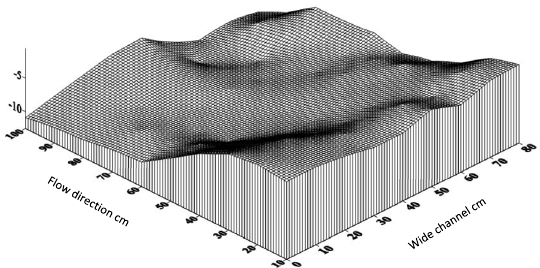
Fig. 6 3D model of bed channel downstream sharp-crested weir at apron solid 100-cm length, 25-cm weir height, and discharge 25 l/s